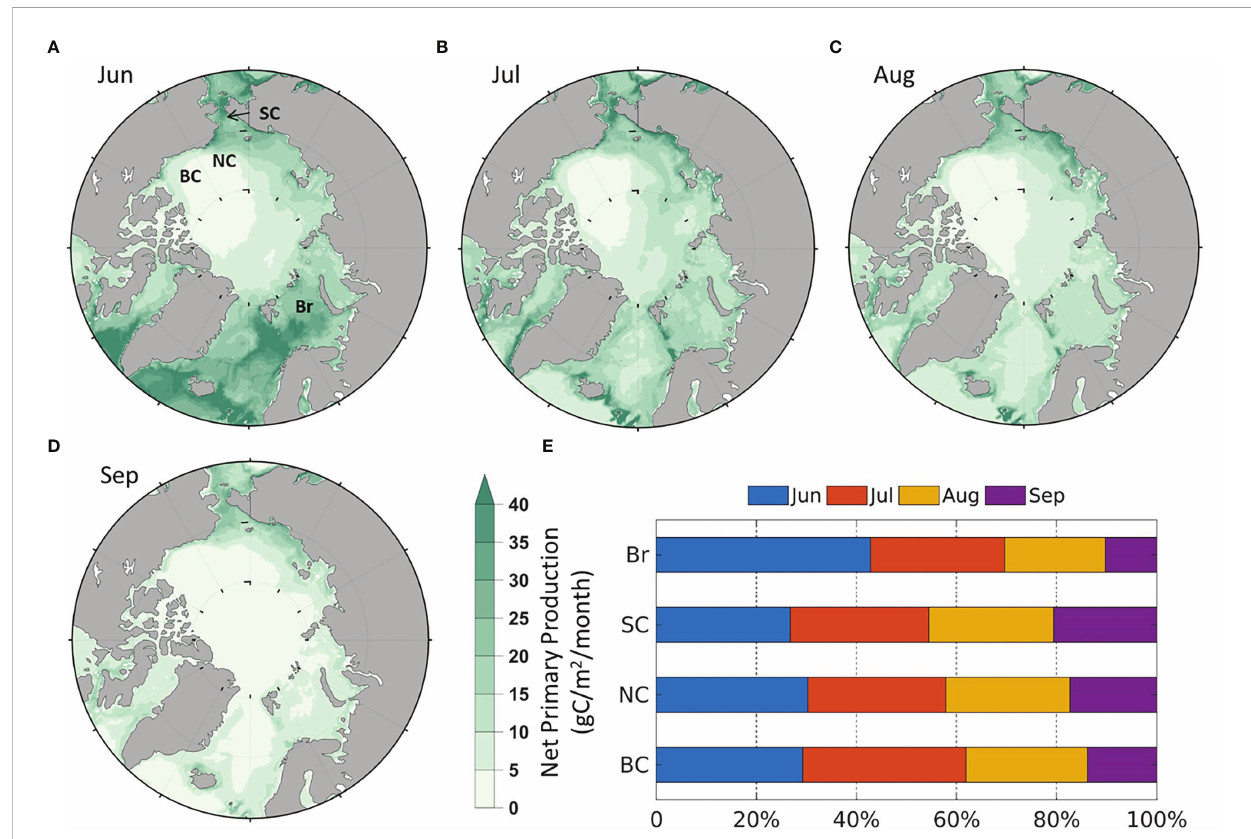
FIGURE 2 Modeled average monthly NPP (1990-2014) in (A) June; (B) July; (C) August; (D) September; (E) Average percentage of monthly contribution to the summer NPP by